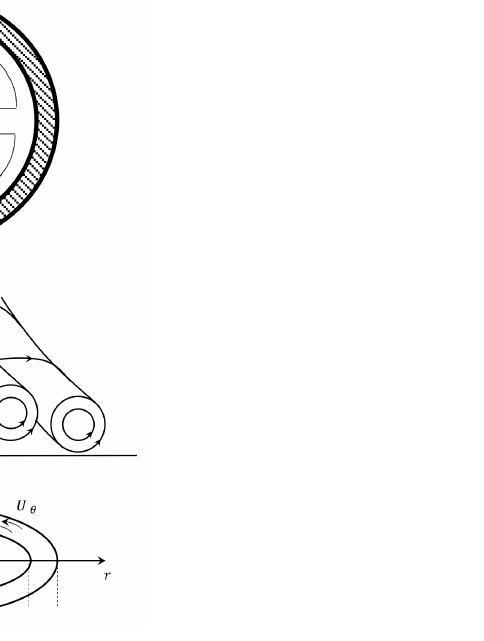
Figure 2. From bottom to top; Taylor vortices, Dean Vortices, and Görtler Vortices at a concave